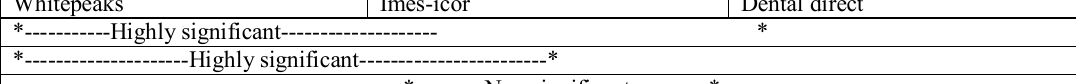
Figure 11: LSD test between (whitepeaks, Imes-icor and dental direct)